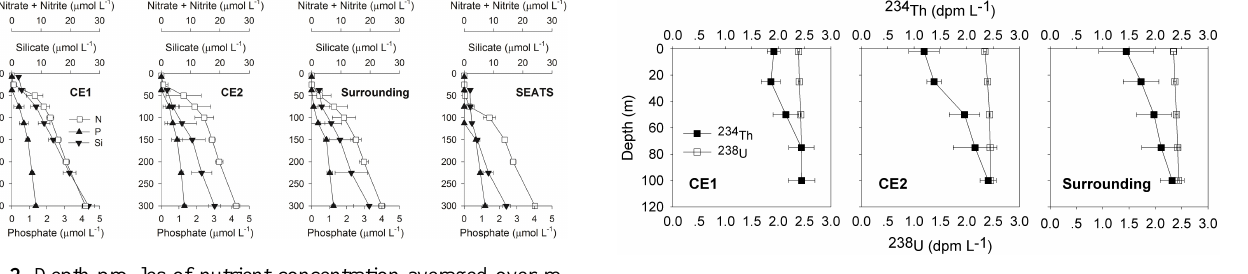
Fig. 4. Depth profiles of 234 Th and 238 U activities averaged over respective stations inside and outside the eddies. Error bars indicate standard deviations.